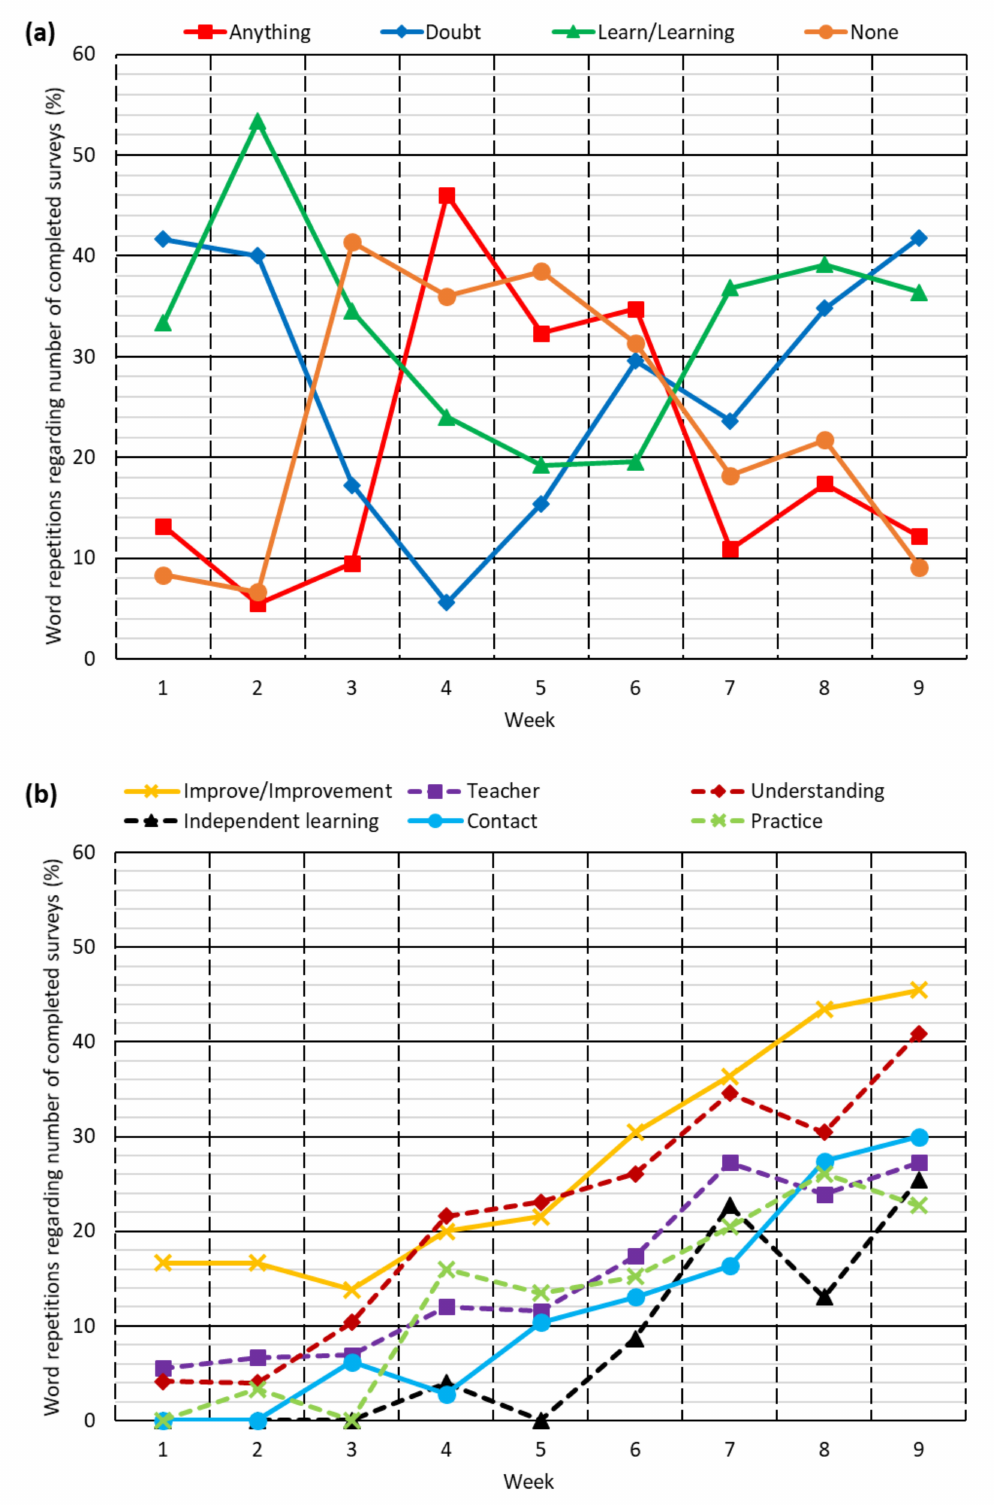
Figure 6. Word counting for answers to question 4: ( a ) words linked to the three phases of behavior; ( b ) words showing the appearance of reflective attitudes among